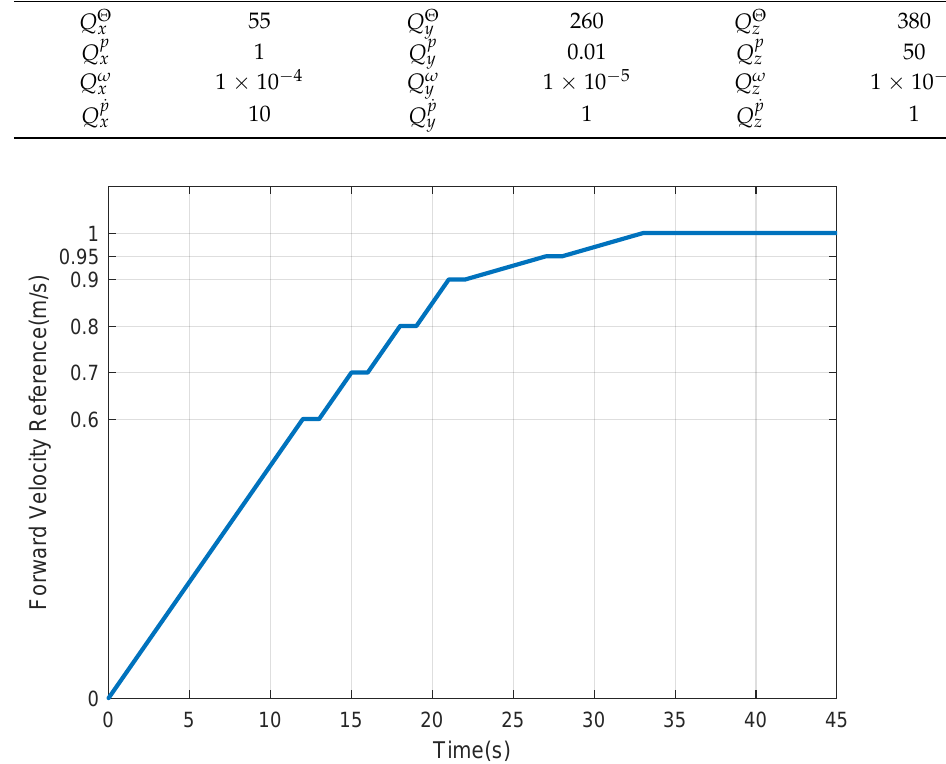
Figure 6. Forward velocity reference. Before the velocity reaches 0.9 m/s, the expected acceleration is 0.05 m/s 2 ; after the velocity reaches 0.9 m/s, the expected acceleration is 0.01 m/s 2